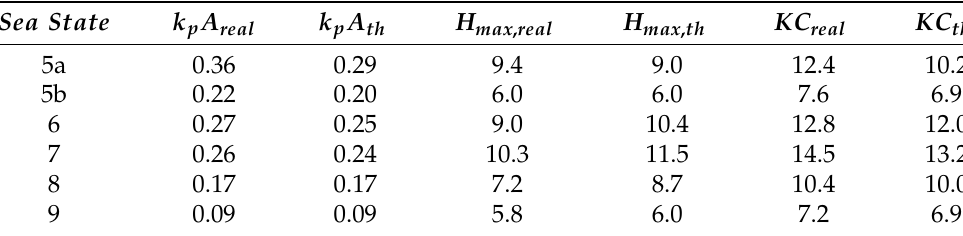
Table 5. Steepness ( k p A ) and maximum wave height ( H max ) for the focused wave group as calculated by the NewWave theory and the numerical solution (CFD).